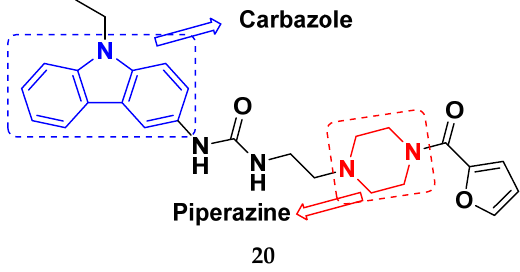
Figure 23. A carbazole ‐ piperazine hybrid ( 20 ).